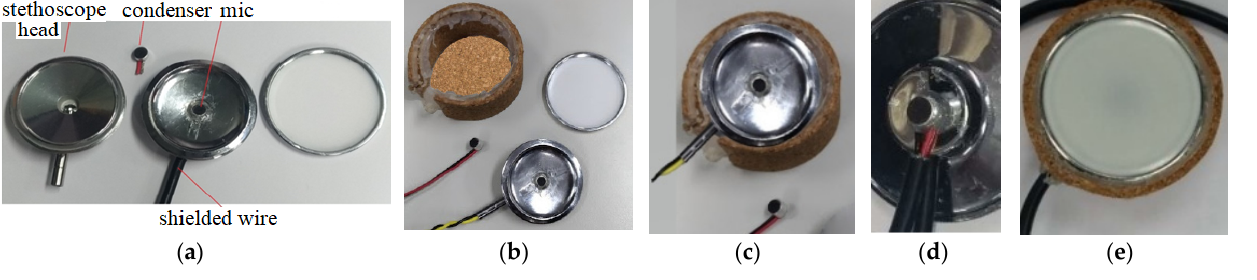
Figure 2. Condenser microphone placed in stethoscope. ( a ) a mic put into a stethoscope head, ( b ) a stethoscope head with mic 1 inside, the cork, and the diaphragm, ( c ) the edge of a head (face up) surrounded by the cork, ( d ) the back of the head attached to a microphone (mic 2), and ( e ) the front of the head encased with the diaphragm; the edge of the head surrounded by the cork